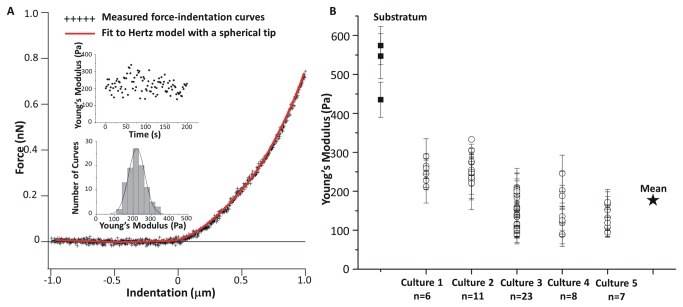
Elasticities of neuron somata.(A) Representative measured force-indentation data with a fit (red solid curve) to the Hertz model. Insets show the individual data points and histogram for 100 force-indentation data collected over a 200 s period time on the same neuron (from Cell Culture Plating 3). (B) Young’s moduli of 54 neuronal somata from five independent cell culture platings and a comparison with the background cellular substratum. The Young’s modulus varies from neuron to neuron and among different culture batches. Error bars are standard deviations for each neuron.